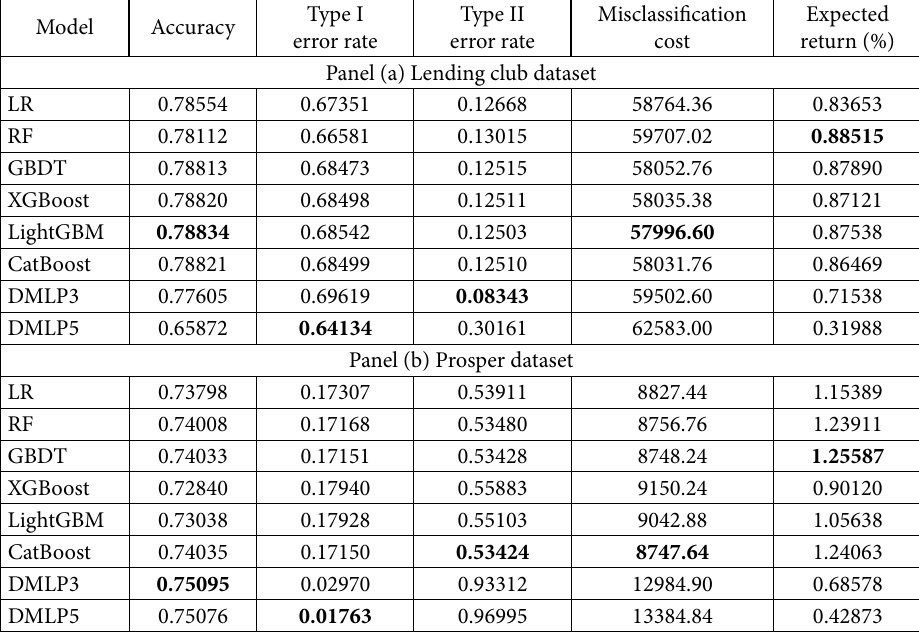
Table 7. Results of out-of-sample validation for Lending club and Prosper dataset (cut-off value modi- fication)